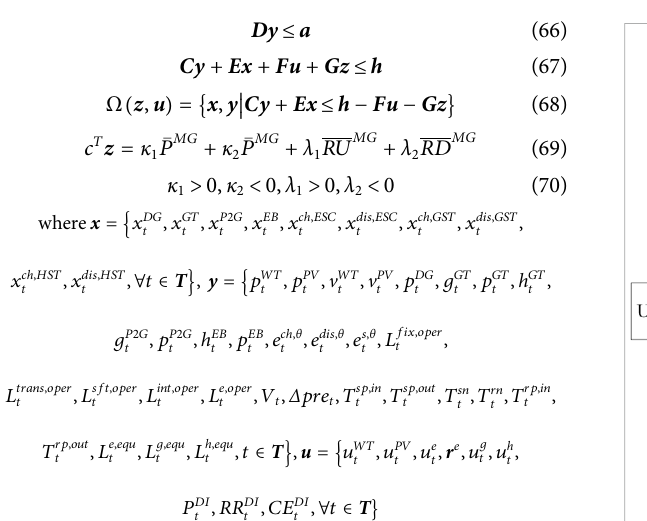
FIGURE 3 Solving procedures of C&CG